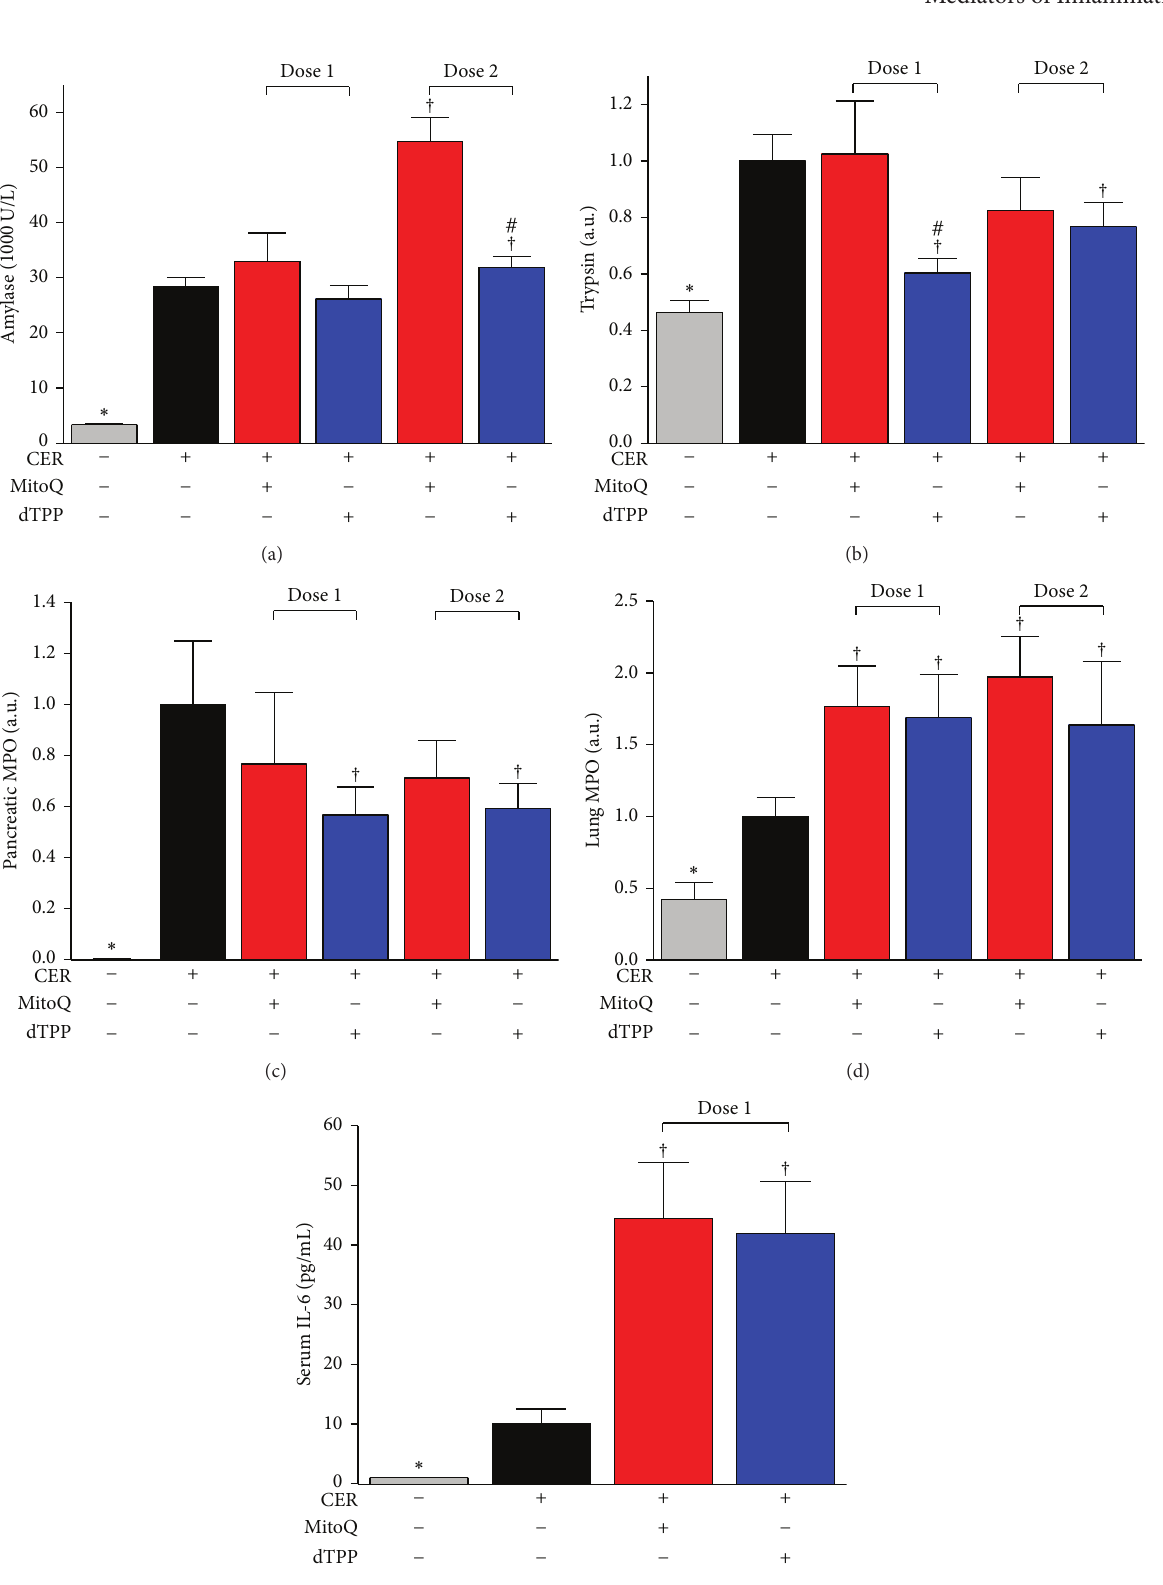
Figure 5: Effects of MitoQ on biochemical markers of CER-AP. (a) Serum amylase. (b) Pancreatic trypsin activity (normalised to CER-AP group). (c) Pancreatic and (d) lung MPO activity (both normalised to CER-AP group). (e) Serum IL-6 levels. ∗ 𝑃 < 0.05 when compared with all other groups, † compared with CER-AP group, # compared with MitoQ group at the same dose. Values are the mean ± SEM ( 𝑛 = 6 mice per